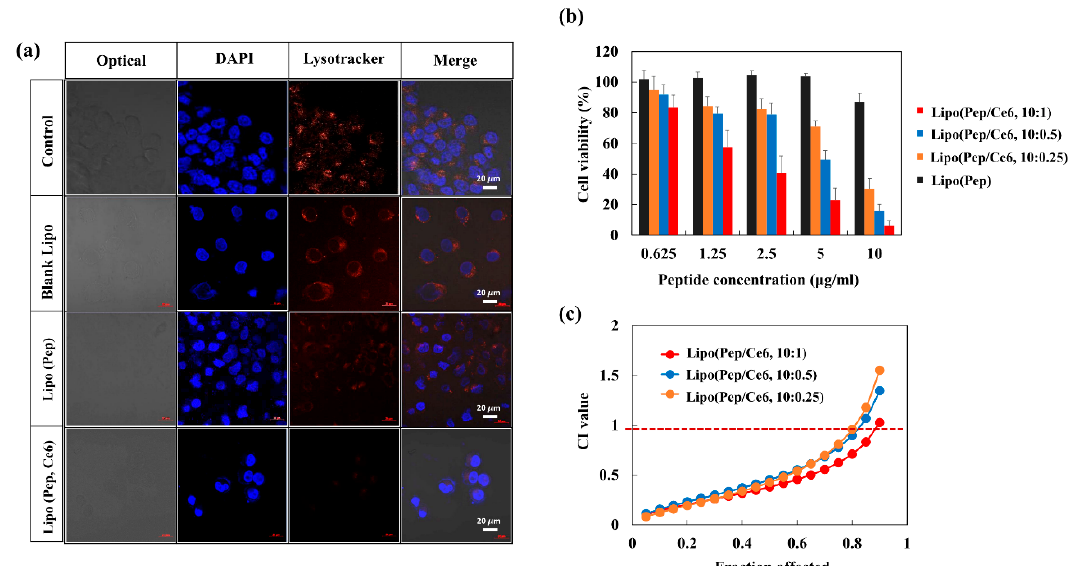
Figure 6. ( a ) Optical and fluorescence images of KB cells treated with blank liposome, Lipo (Pep) or Lipo (Pep, Ce6). ( b ) The cell viability of KB cells treated with Lipo (Pep) or Lipo (Pep, Ce6) at different drug loading ratio (5.2 mV, 100 s laser exposure time). ( c ) Plot of CI values for combination therapy at different peptide/Ce6 mixing ratio.